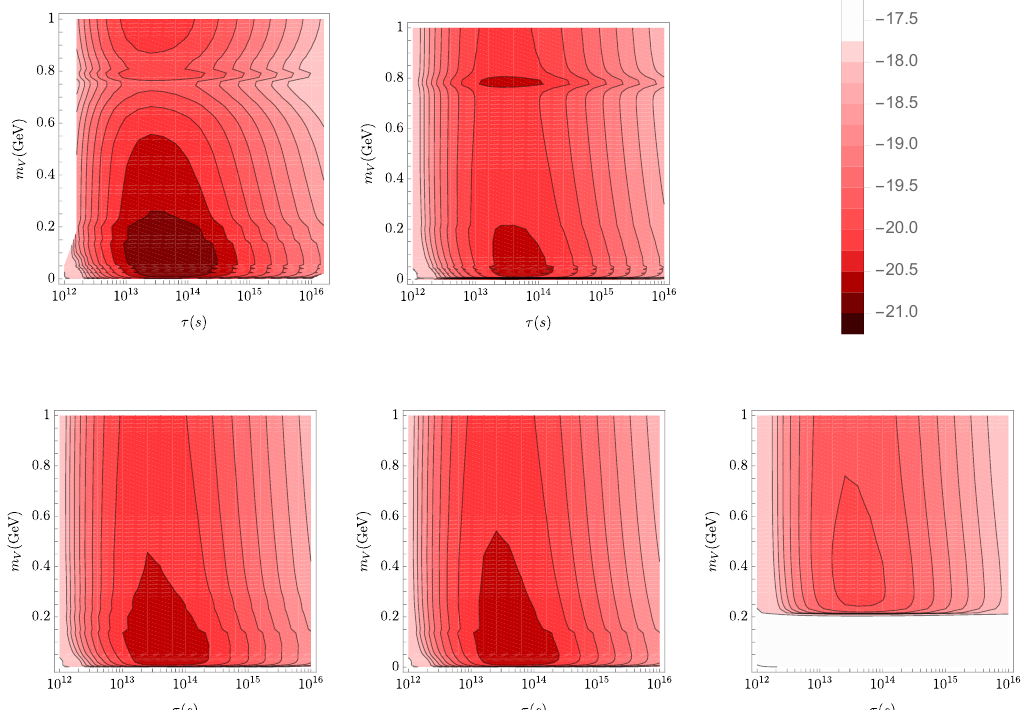
Figure 4 . Estimated CMB upper bounds from Planck on the mass times yield log of sub-GeV dark vectors in the lifetime-mass plane for the dark vector species DP (upper left), B (cid:0) L (upper middle), L e (cid:0) L (cid:22) (lower left), L e (cid:0) L (cid:28) (lower middle), and L (cid:22) (cid:0) L (cid:28) (lower